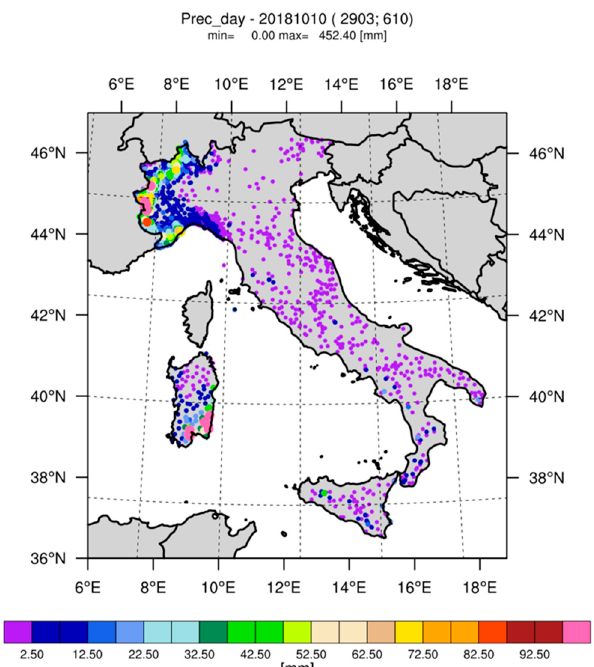
Figure 1. Daily precipitation observed on 10 October 2018. The rain gauge network is managed by the Civil Protection Department and has more than 3000 rain gauges over Italy. Only rain gauges recording at least 0.2 mm over the whole day are shown.